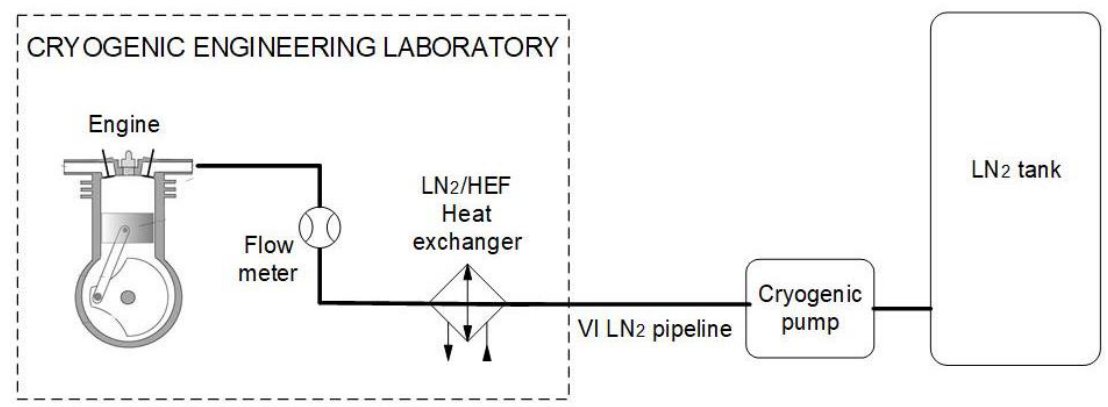
Figure 2. N 2 storage and supply subsystem.